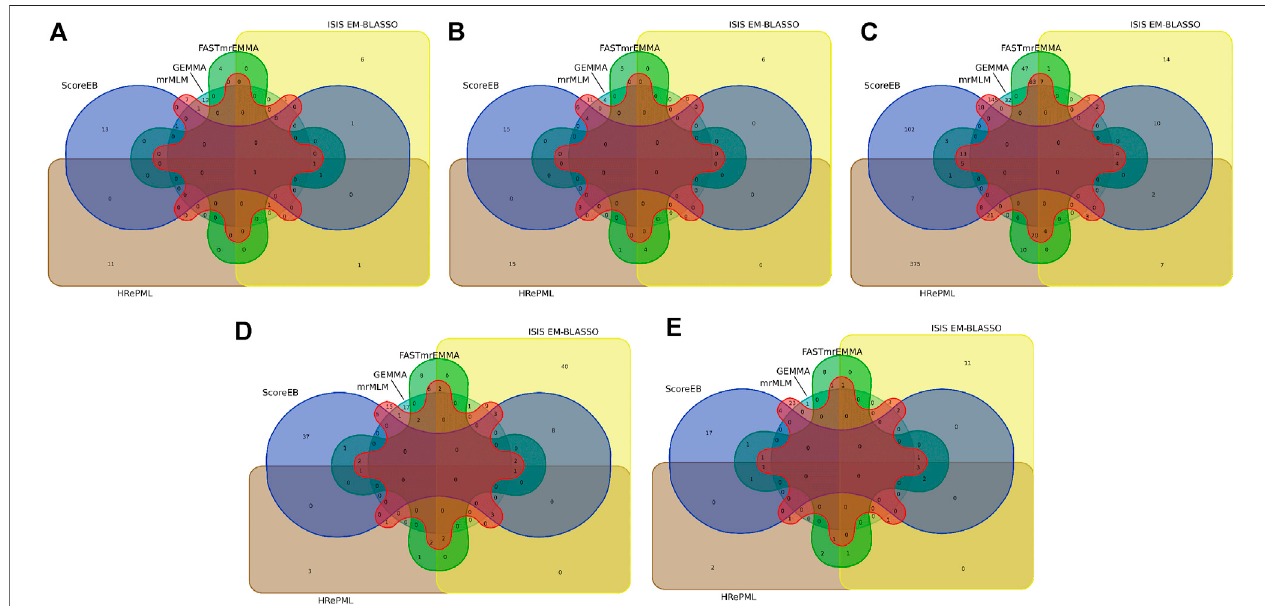
FIGURE 3 | Venn diagram of nearby candidate genes or QTLs identi fi ed by six methods (ScoreEB, mrMLM, FASTmrEMMA, ISIS EM-BLASSO, HRePML and GEMMA) on quantitative traits in Arabidopsis (A) , rice (B) , maize (C), cattle (D) and pig (E).